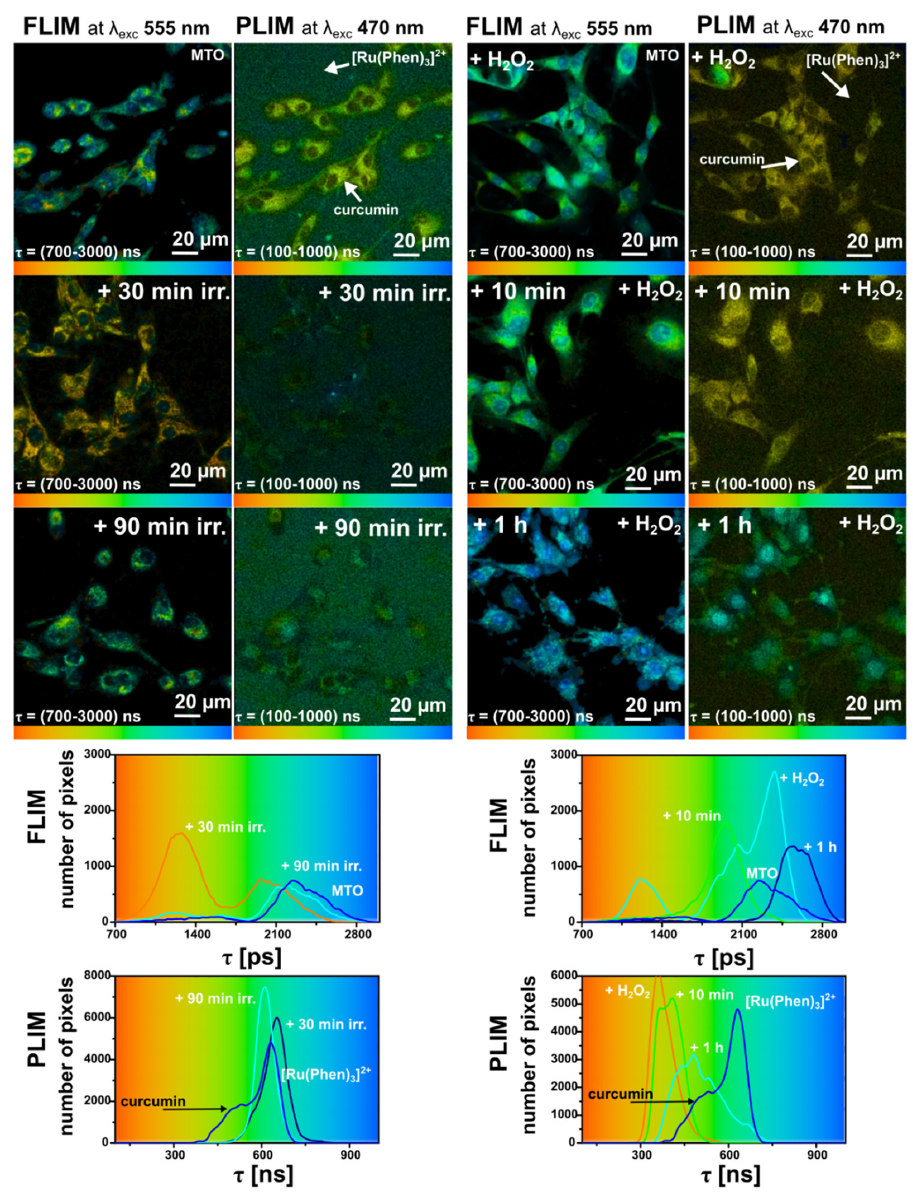
Figure 11. Illustrative FLIM images of MTO and PLIM images of [Ru(Phen) 3 ] 2+ both applied in the medium of U87 MG cells for 30 min in the presence of 10 µM curcumin. The phosphorescence of curcumin (localized only in cells) was detected in the same channel as [Ru(Phen) 3 ] 2+ . The cells were irradiated 30 and 90 min with blue light, 463 ± 10 nm with an irradiance of 100 µW/cm 2 (six images in the upper left). Alternatively, the cells were stressed (six images in the upper right) with 200 µM H 2 O 2 (10 min and 1 h after H 2 O 2 administration). FLIM and PLIM luminescence lifetime histo- grams are plotted for both conditions (below the images). The luminescence lifetimes are color- coded (minima—red, maxima—blue).